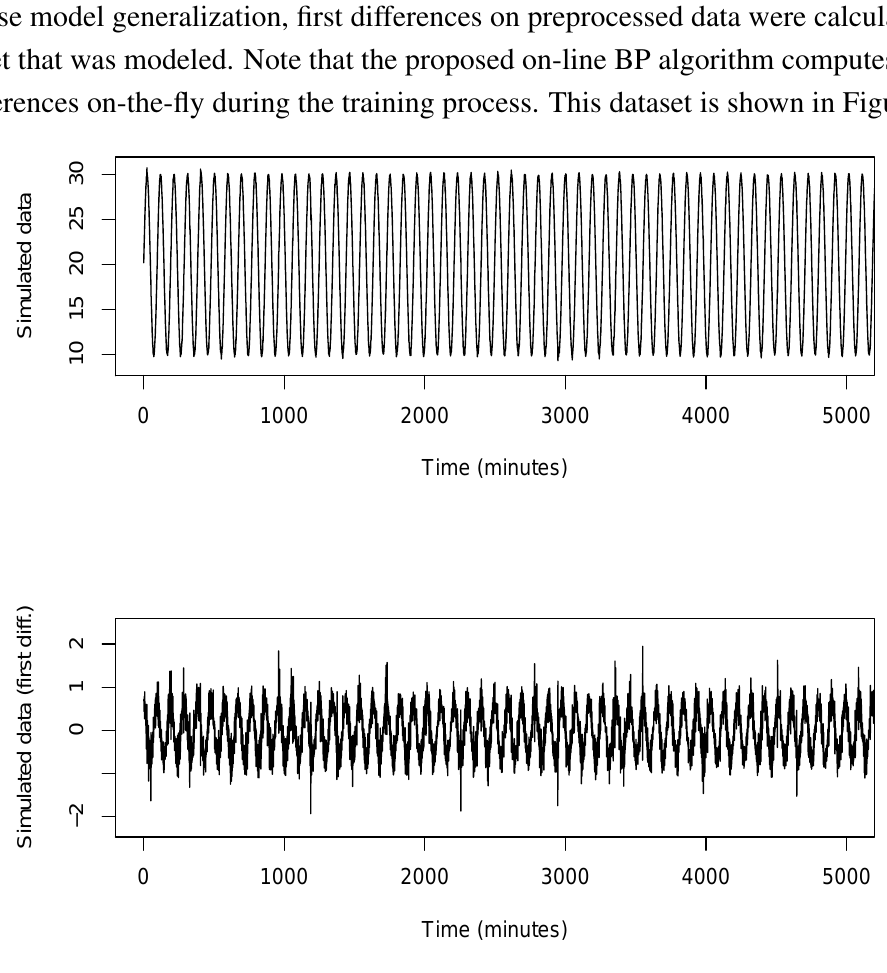
Figure 8. First 5000 simulated time series data and first